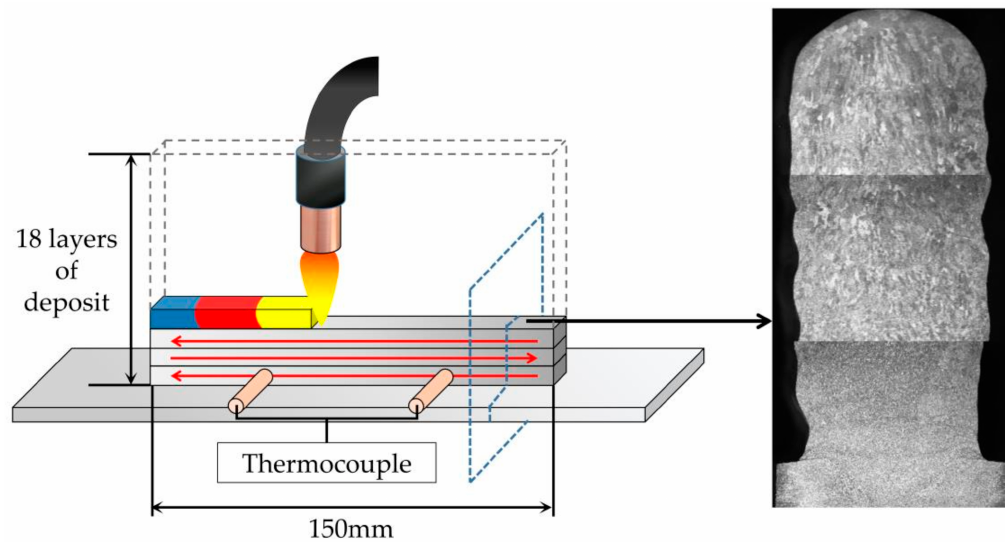
Figure 2. Schematic diagram of deposition process and specimen